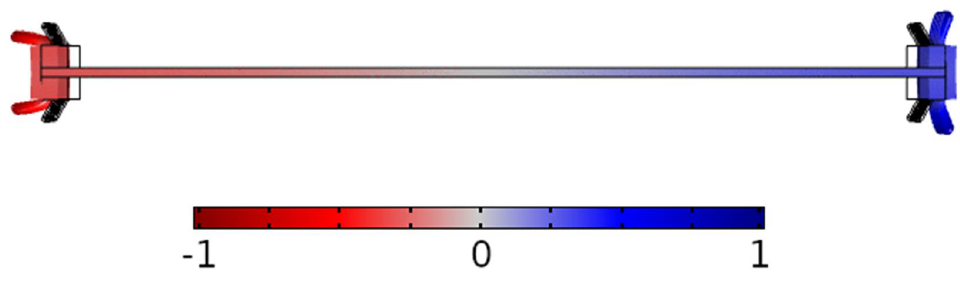
Figure 4. Side view capture of the normalized displacement of the first extensional mode of the PZT plate together with the symmetric legs configuration.